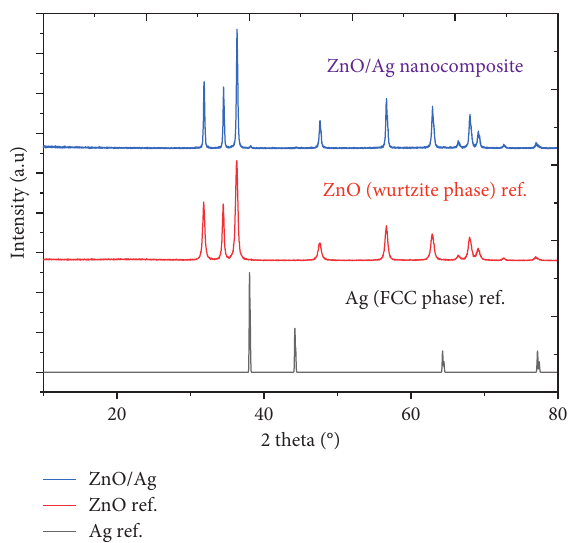
Figure 2: XRD pattern of ZnO/Ag nanocomposite in correlation with the wurtzite phase of ZnO and the face centered cubic (FCC) phase of Table 1: XRF analysis of the components of copper oxide/silver and zinc oxide/silver (ZnO/Ag) nanocomposites.